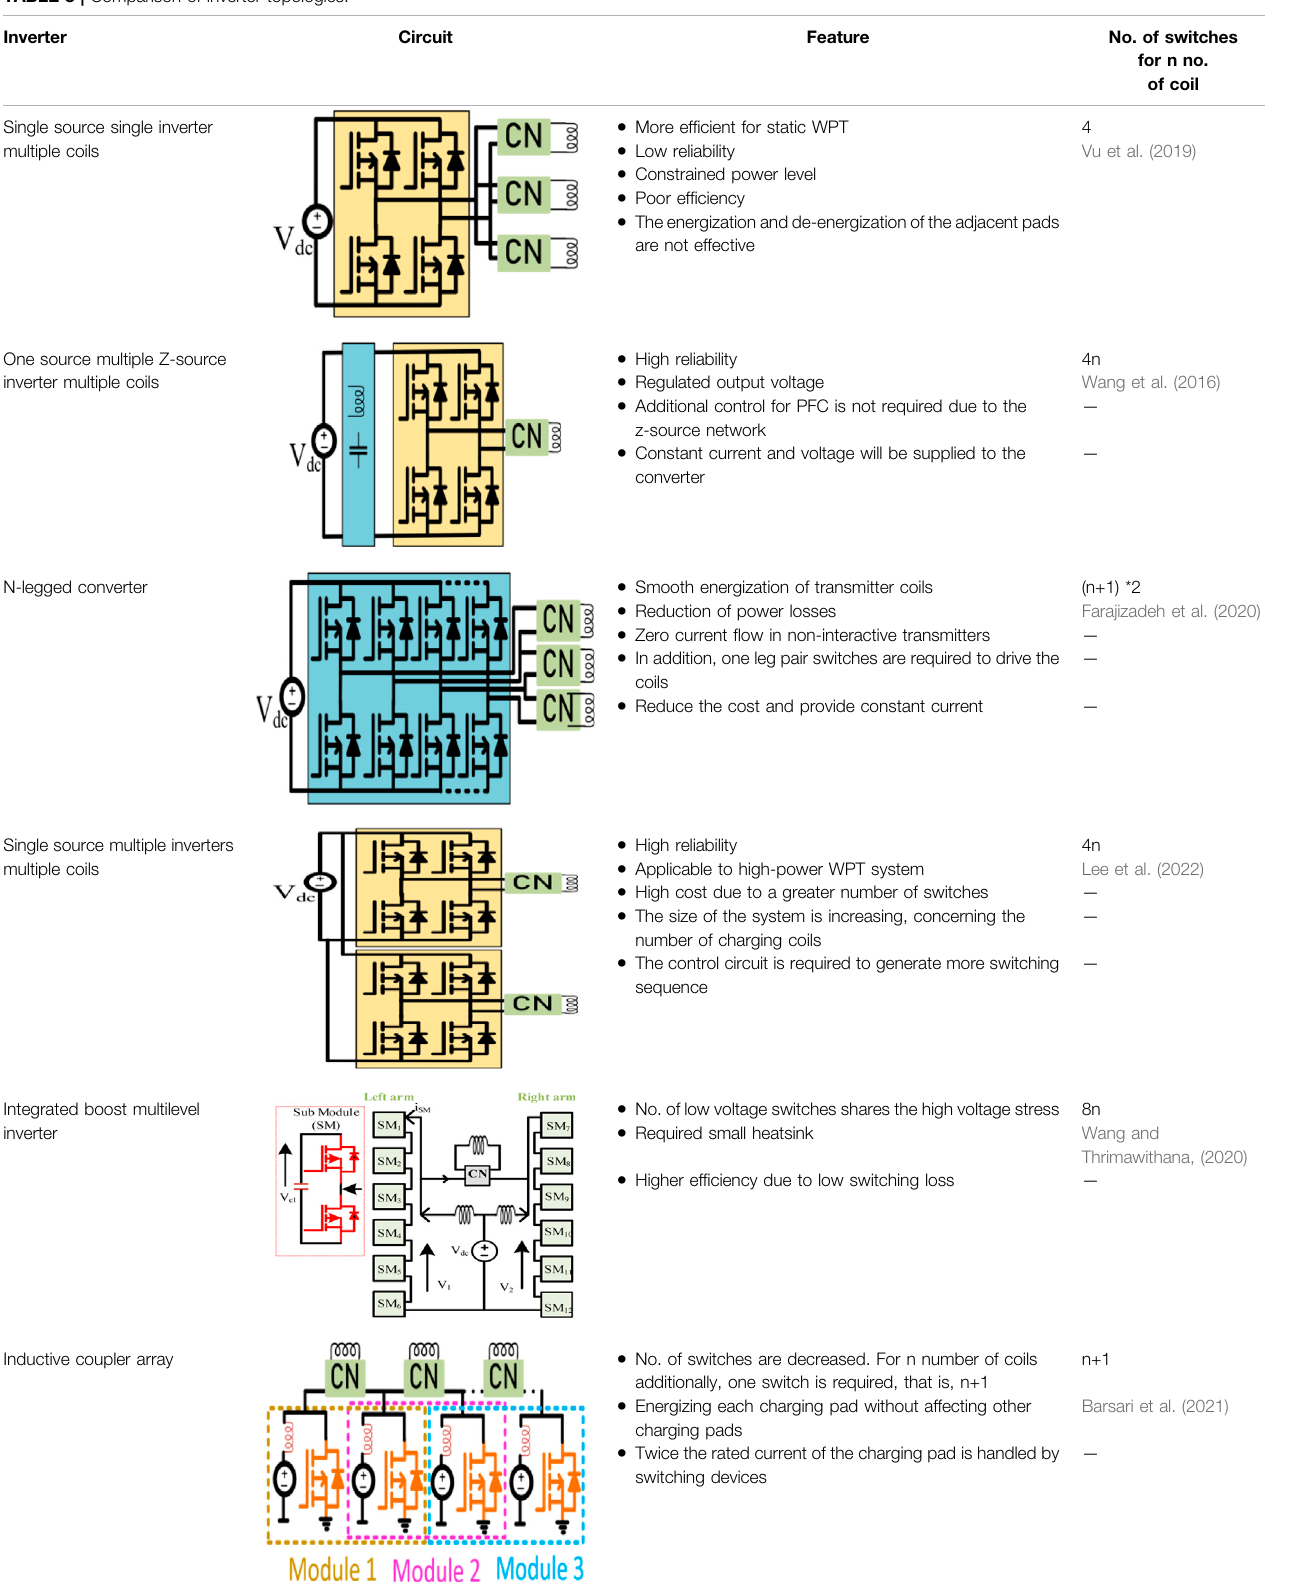
TABLE 8 | Comparison of inverter